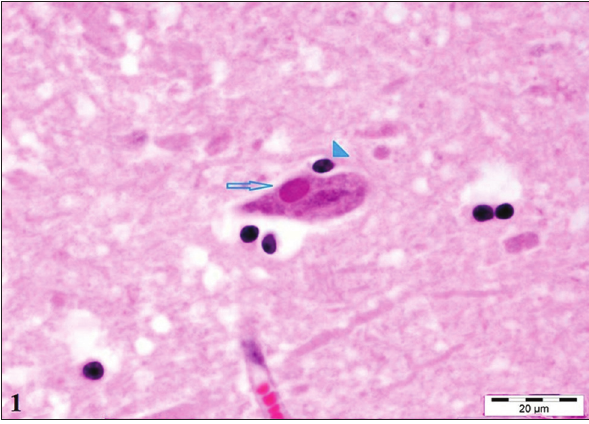
Figure-1: Section of the hippocampus of rabid cattle showing sharply Negri body and neuronophagia